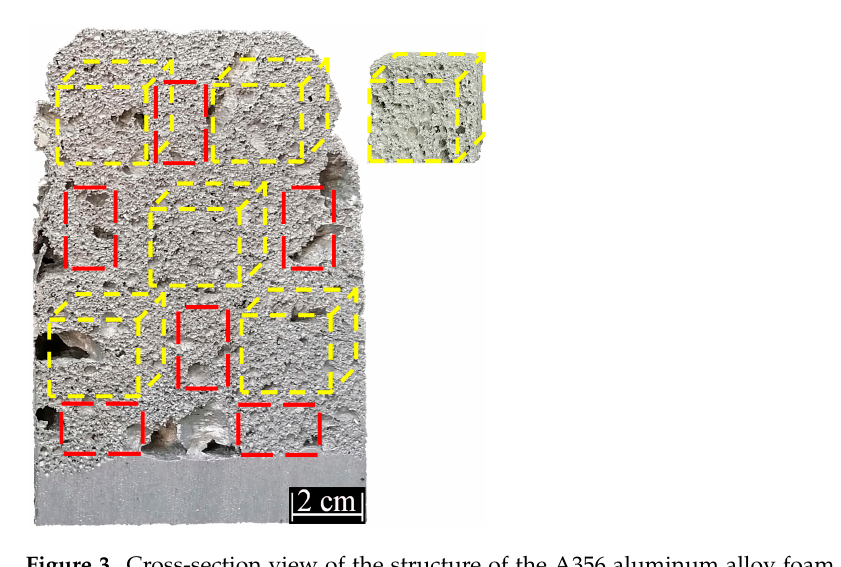
Figure 3. Cross ‐ section view of the structure of the A356 aluminum alloy foam showing sample Figure 3. Cross-section view of the structure of the A356 aluminum alloy foam showing sample locations for microstructural characterization and compressive trials. locations for microstructural characterization and compressive